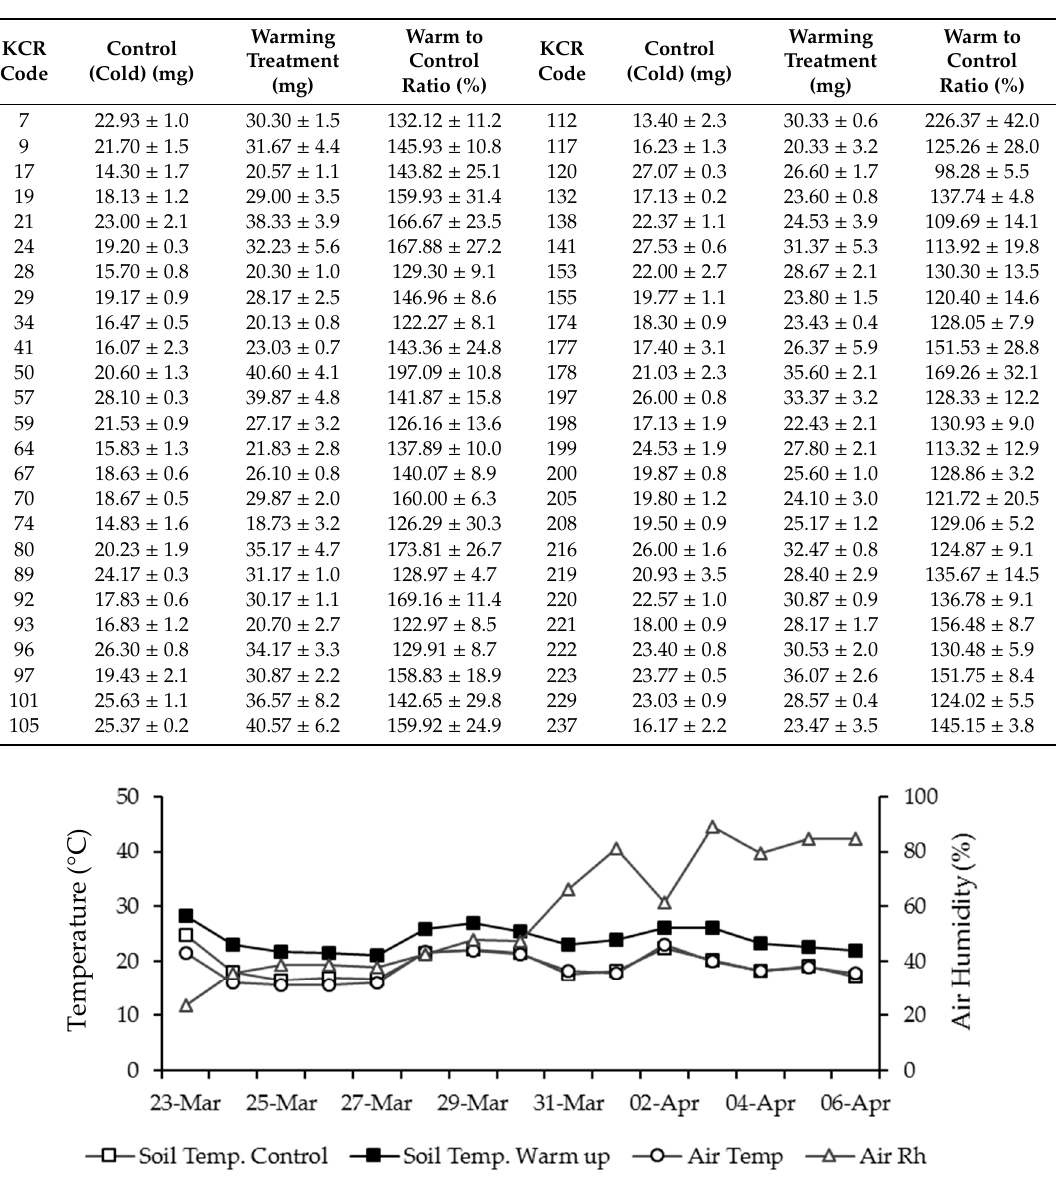
Figure 6. Environmental condition in warming treatment period. 210